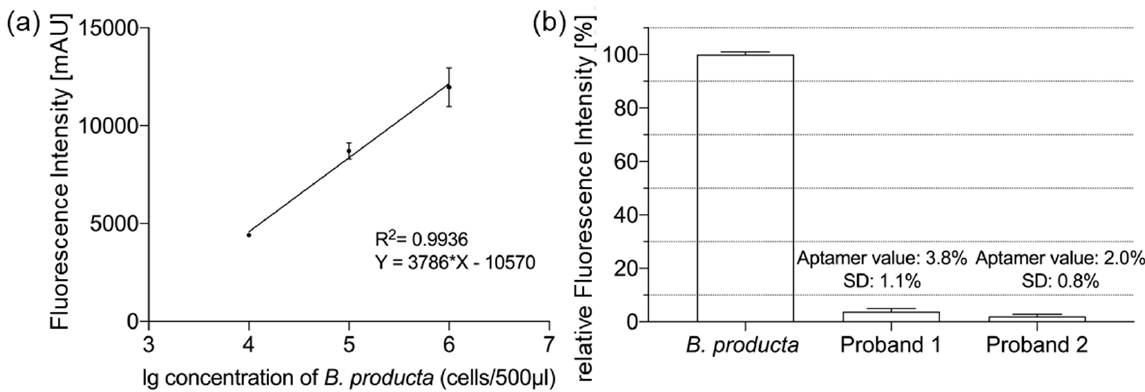
Figure 4. ( a ) Aptamer B.p ‐ R14 sensitivity assay, the decrease of fluorescence intensity depends on the decrease of cell concentration, the solid line is the calibration curve obtained from the correlation between cell concentration and fluorescence intensity change, the bacterial concentration is positively correlated with fluorescence intensity when the number of bacteria in 500 μ L 1x DPBS varies in the range of 10 4 to 10 6 cells. The detection limit of the aptamer library B.p ‐ R14 for B. producta was 10 4 cells. ( b ) Blautia abundance in male and female fecal samples based on the aptamer library B.p ‐ R14 and 16S rDNA NGS. The actual value represents the actual Blautia content in fecal bacteria as determined by NGS. The target value shows the Blautia abundance in fecal bacteria as determined by the aptamer library B.p ‐ R14. The SD stands for the standard deviation during the measurement of the target value. All experiments were conducted as triplicates ( n = 3).